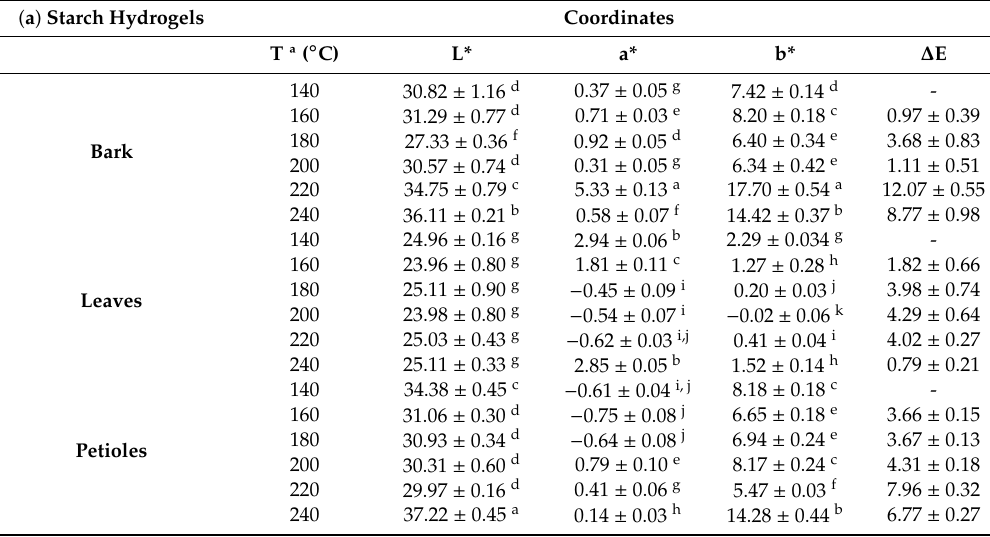
Table 2. Color coordinates by CIEL*a*b* system for hydrogels formulated with starch ( a ) and gelatin ( b ). ( a ) Starch